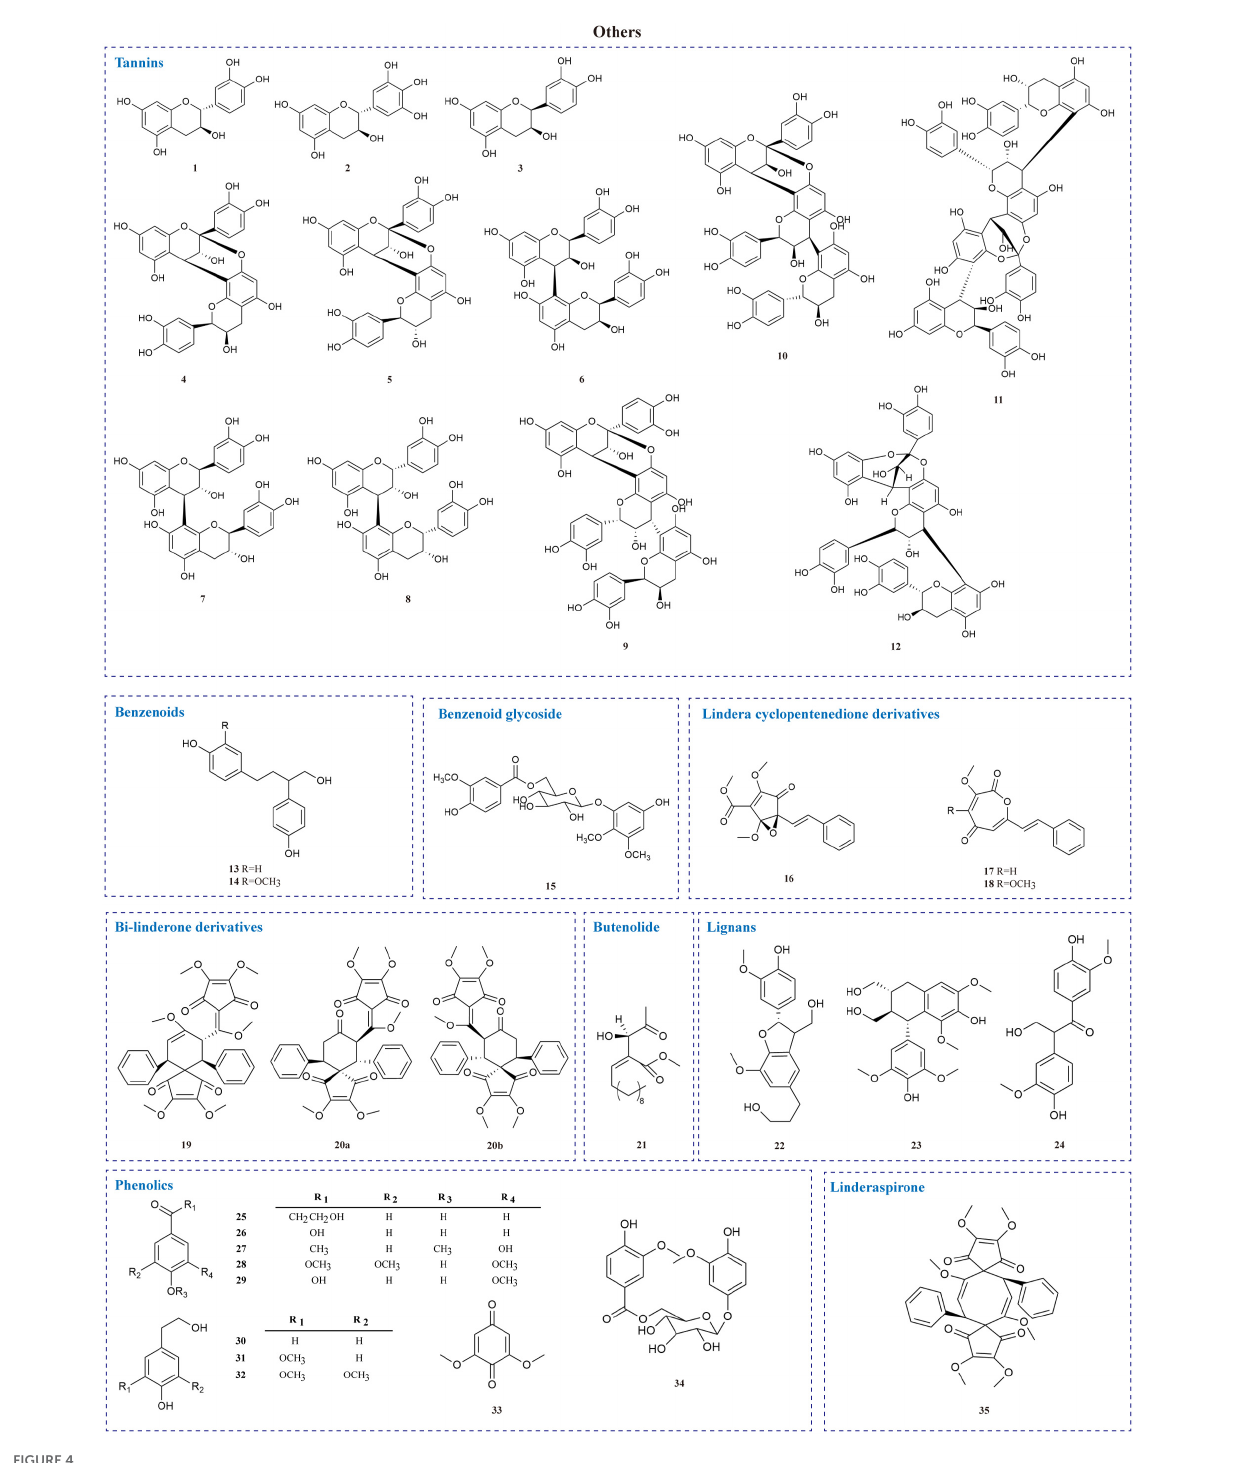
significantly lowered serum TC, TG, LDL, non-HDL, alanine aminotransferase (ALT), hepatic lipid/glucose (GLU), apolipoprotein B, hepatic GLU, and increased serum HDL, apolipoprotein A1, and fecal TG levels in HCL mice. The potential cholesterol-lowering mechanism may involve inhibiting cholesterol synthesis by down- regulation of 3-hydroxy-3-methylglutaryl CoA reductase (HMGCR) and promoting cholesterol transport by up-regulation of cholesterol